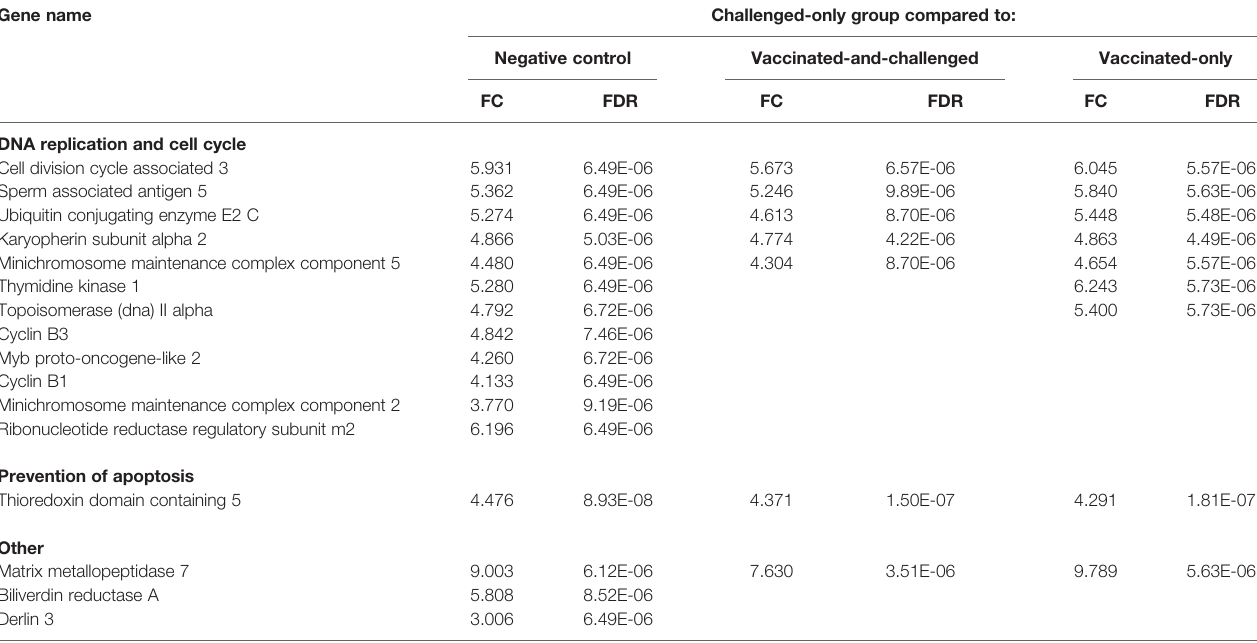
FIGURE 2 | An UpSetR plot displaying the abundances of common and unique signi fi cantly differentially transcribed genes in the challenged-only group compared to the negative control, vaccinated-and-challenged and vaccinated-only groups. Horizontal bars indicate the total number of differentially transcribed genes in each comparison. TABLE 1 | Log 2 fold changes (FC) and false discovery rates (FDR) of t he up-regulated genes among the 25 most differentially expressed genes based on FDR in the challenged-only group compared to the other